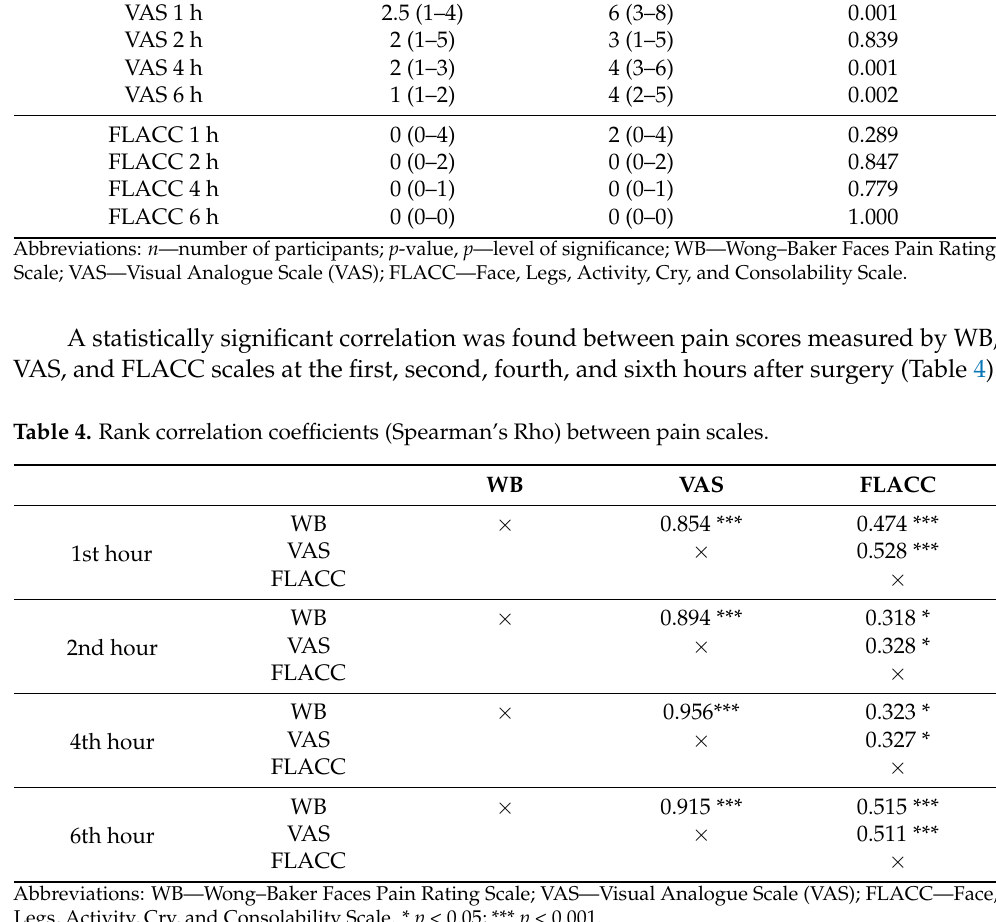
Pain Measurement Scale